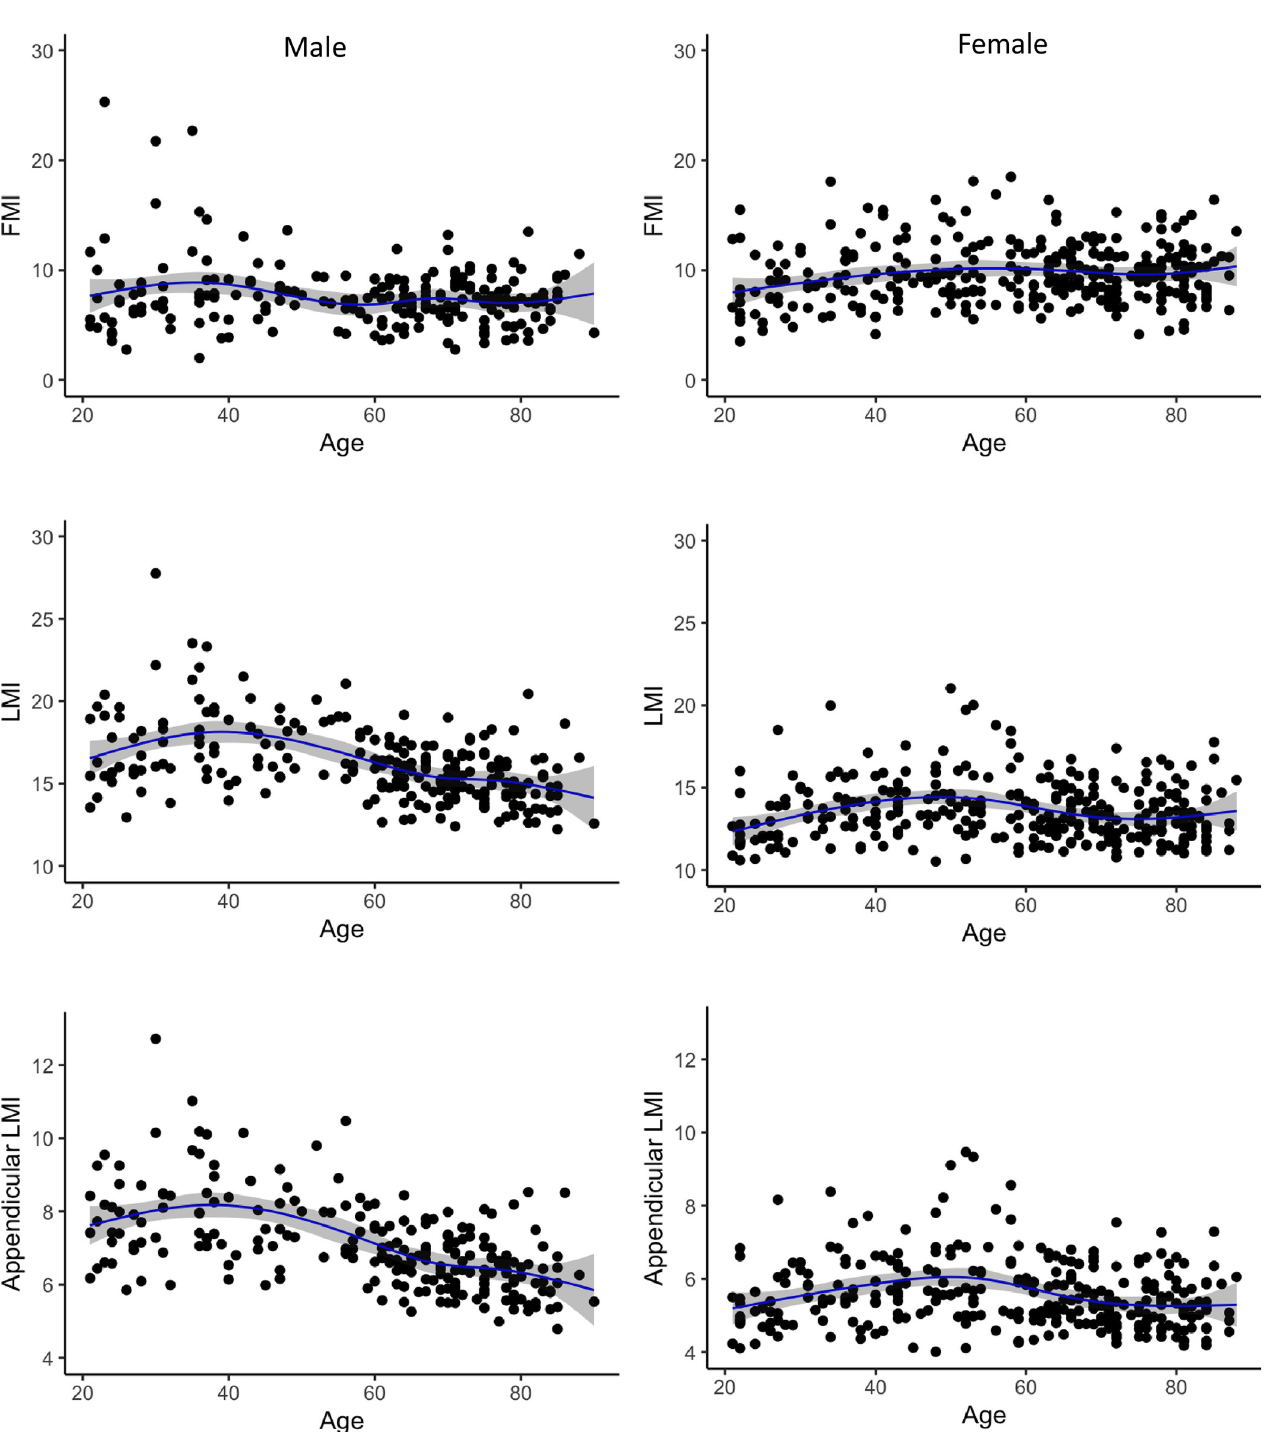
Fig 1. Natural spline regression by sex for FMI, LMI, and appendicular LMI in men and women aged 21–90 years. FMI, fat mass index; LMI, lean mass index.